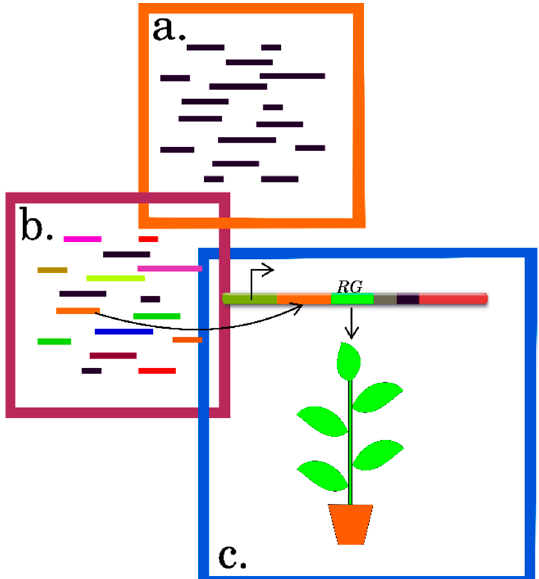
Figure 8. General strategy for identification, prediction, and experimental verification of the functional elements within transcripts that mediate their efficient translation. ( a ) Primary data on the transcripts differing in their translation efficiencies are obtained by sequencing the pools of the transcripts generated by polysome profiling, TRAP, or ribosome profiling. ( b ) In silico analysis of the transcript sequences identified the functional elements of transcripts. ( c ) Experimental verification of the predicted functional elements within transcripts (case study of reporter systems).